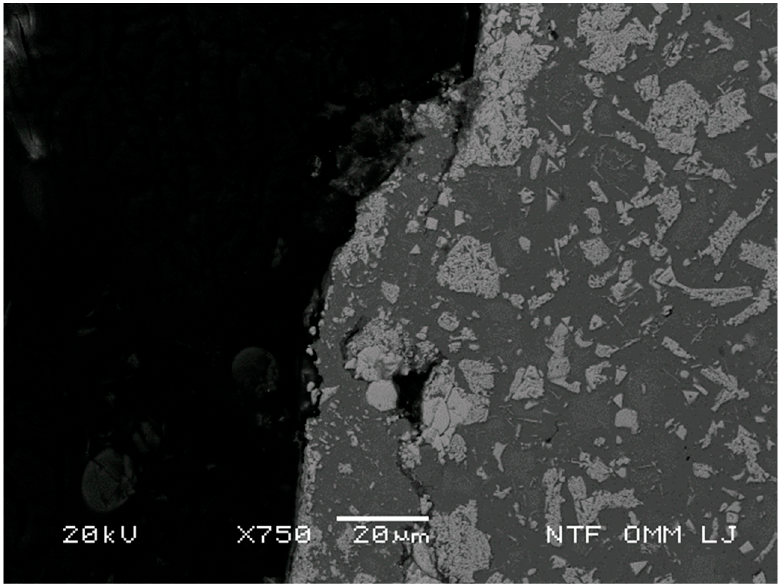
Figure 14. Formation of micro erosion channels in carbide coating matrix.